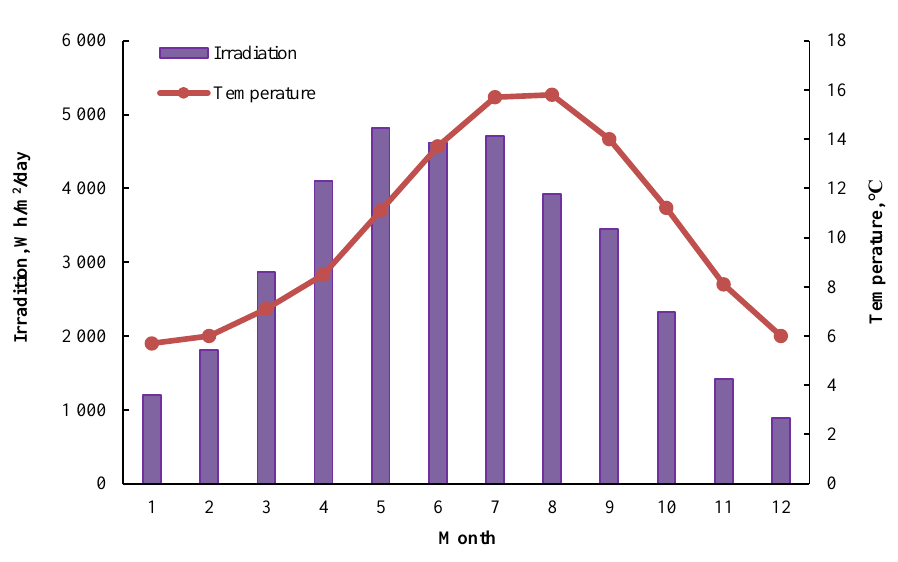
Fig. 2. The annual electricity load of 20 buildings in the community.